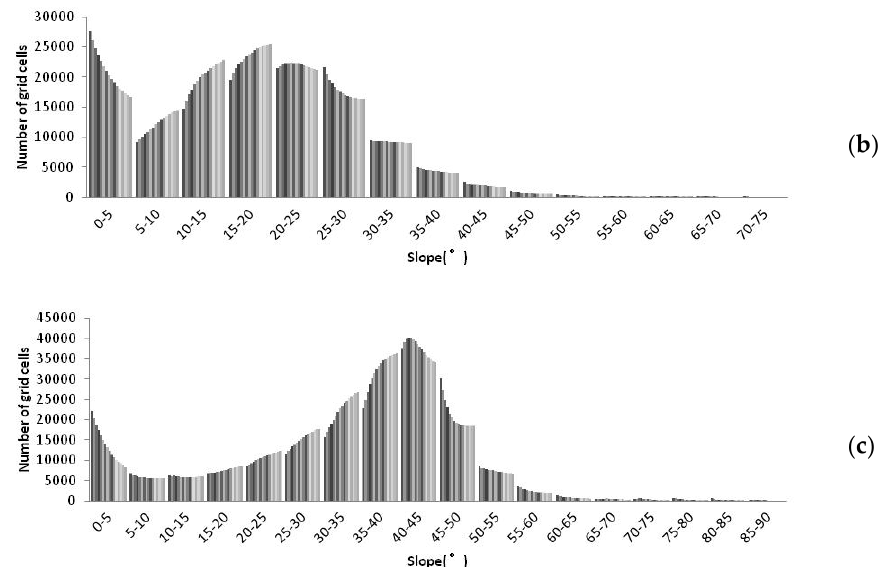
Figure 8. Histogram of slope grade with number of grid cells in study areas 1–3. There are 5 ◦ per grade. The columns from left to right in each group respectively correspond to the number of grid cells of each slope grade in slope i (i = 5, 6, 7, ... , 20). Histograms of ( a ) study area 1, ( b ) study area 2, and ( c ) study area 3. Table 8. Functional relationship between mean aspect ( y ) and number of points in the neighbourhood ( x ) in study areas 1–3 and simulated data.